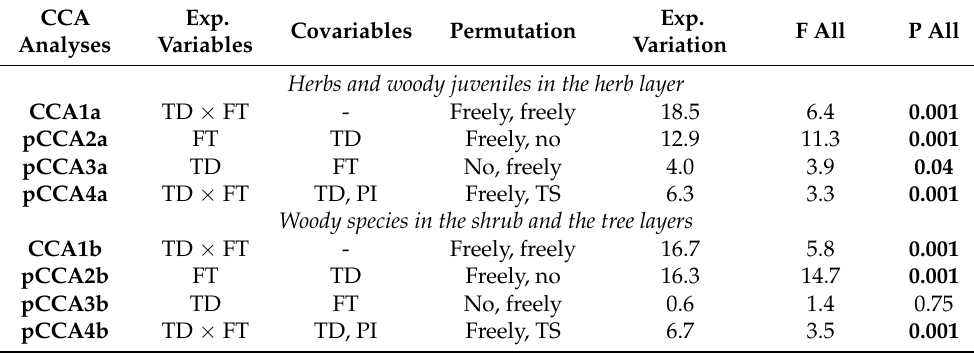
Table 3. Summary of the results of the canonical correspondence analyses (CCA, pCCA) for floristic composition sampled in 36 permanent plots. Small letters indicate subsets of response variables: (a) species in the herb layer; (b) species in the tree and shrub layers. Explanatory variables (Exp. variables) used in the test: typhoon disturbance (TD); forest type (FT). The interaction of typhoon disturbance × forest type (TD × FT) is the interaction of each level of one variable with each level of the other. Covariables: plot identity (PI). Permutation (type of permutation within plots used in the Monte Carlo test) reflects the repeated measurement nature of the data (i.e., used split-plot design permutation). Here, we present permutation at the whole plot level and permutation on the split-plot level. On the split-plot level, TS means permutation restricted to times series (before–after TD) and dependent across whole plots. Explained variation (Exp. variation): % adjusted explained variation. F all, P all: values of the F-test and p -values on all ordination axes,